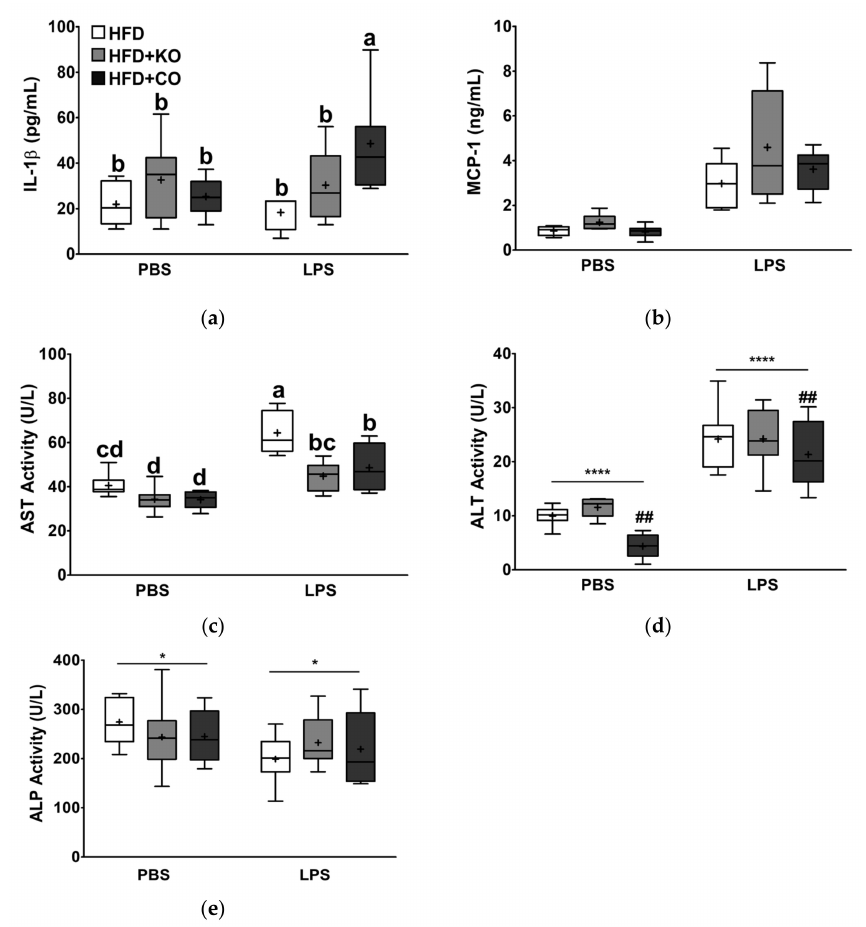
Figure 5. Effects of partial replacement of dietary fat with krill oil or coconut oil on serum proinflam- matory cytokines, chemokine, and hepatic function enzyme levels in rats after the LPS challenge. Sprague Dawley rats were fed either a high-fat diet (HFD), HFD partially replaced with krill oil (HFD + KO), or coconut oil (HFD + CO) for 10 weeks, and then treated with PBS or LPS (1 mg/kg) for 24 h. ( a ) Interleukin (IL)-1 β levels, ( b ) monocyte chemoattractant protein (MCP)-1 levels, ( c ) aspartate aminotransferase (AST), ( d ) alanine aminotransferase (ALT), and ( e ) alkaline phosphatase (ALP) activities were analyzed. Values are displayed as box-and-whisker plots, n = 8 per individual group. Data were analyzed by two-way ANOVA followed by Tukey’s multiple comparisons test to determine the interactions or the main effects (diet and LPS stimulation). Asterisk indicates a significant main effect for LPS (* p < 0.05, **** p < 0.0001). Pound indicates a significant main effect for diet ( ## p < 0.01). Labeled means without a common letter differ significantly, p < 0.05. The mean values are indicated by “+” signs. HFD, high-fat diet; HFD + KO, high-fat diet + krill oil; HFD + CO, high-fat diet + coconut oil; PBS, phosphate-buffered saline; LPS,